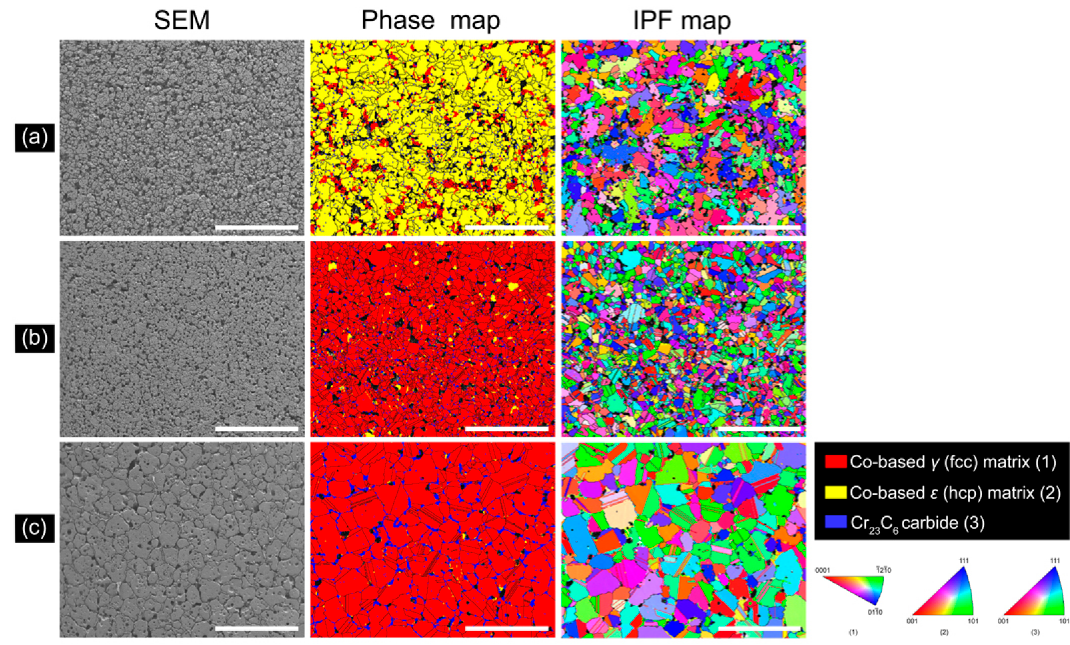
Figure 2. Figure 2. SEM/EBSD images of the Co–Cr alloys prepared at three different post-sintering temperatures : ( a ) 1250 °C; ( b ) 1350 °C; ( c ) 1450 °C (250×, scale bar = 100 μ m).